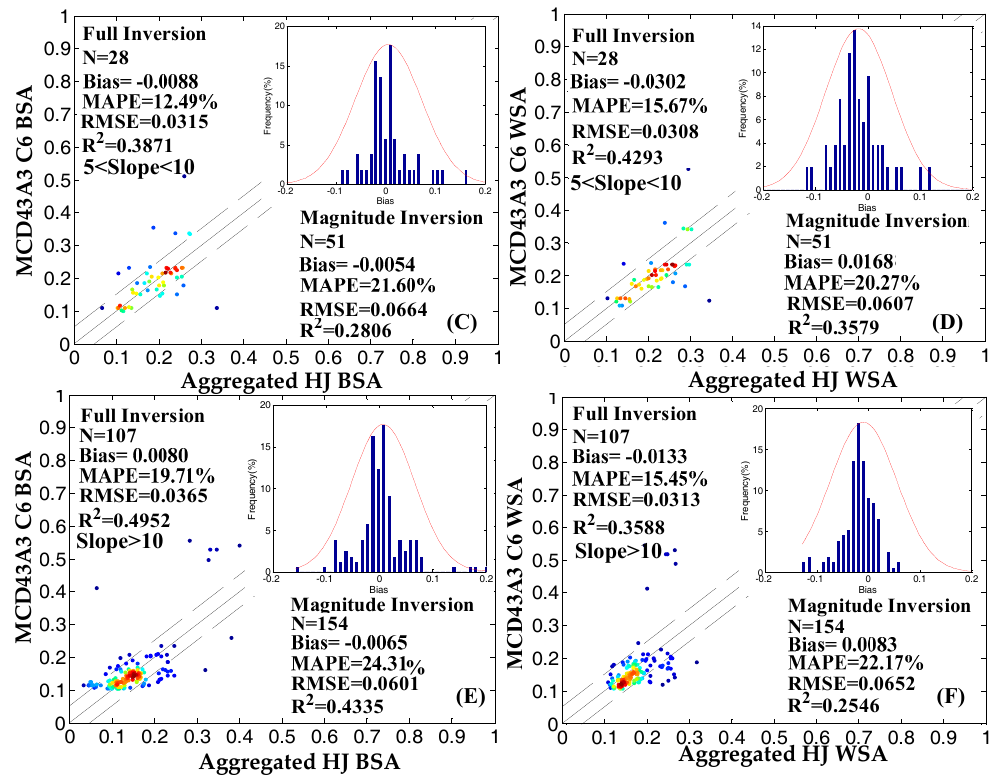
Figure 11. Coarse scale MCD43A3 C6 products validation by comparing with the aggregated fine scale albedo at different mean slopes. The colors refer to the density of points (from highest (red) to lowest (blue).